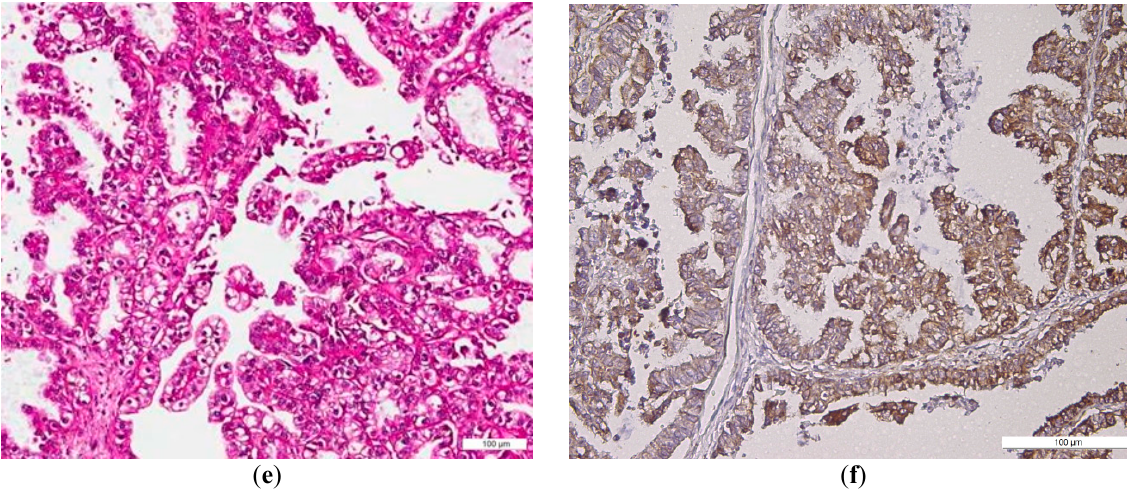
Figure 1. ( a – f ) Histologic features and BMI-1 expression in EOC group in different ovarian tumor subtypes: ( a , b ) HGSC: